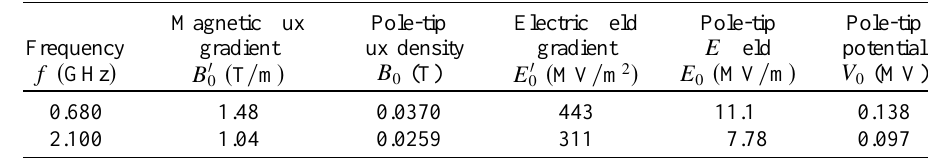
TABLE IV. Magnetic flux densities of electric field required for the rf quadrupoles compensating for the 4-cm